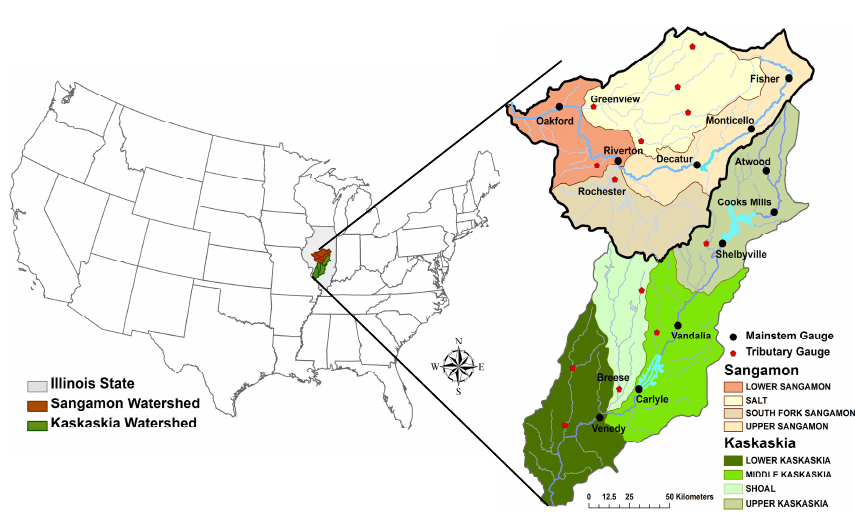
upland topography. In the southern portions of the